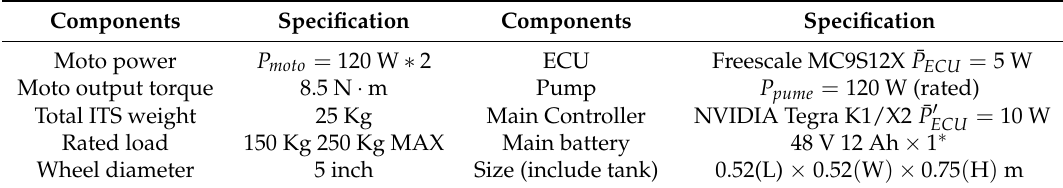
Table 3. Specifications of an experimental agricultural